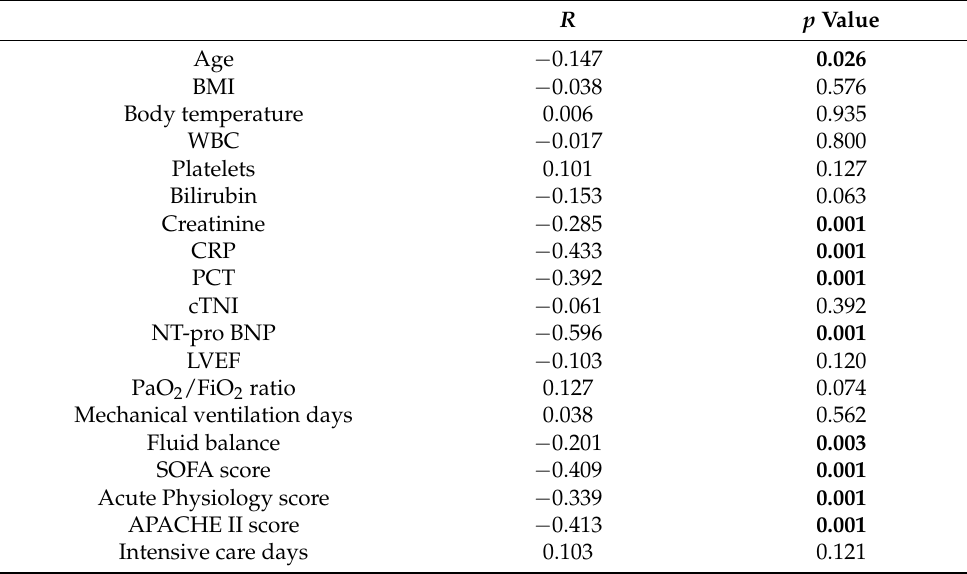
Table 3. Univariate correlations of albumin levels with laboratory and clinical parameters in all patients ( n = 230) at day 1.